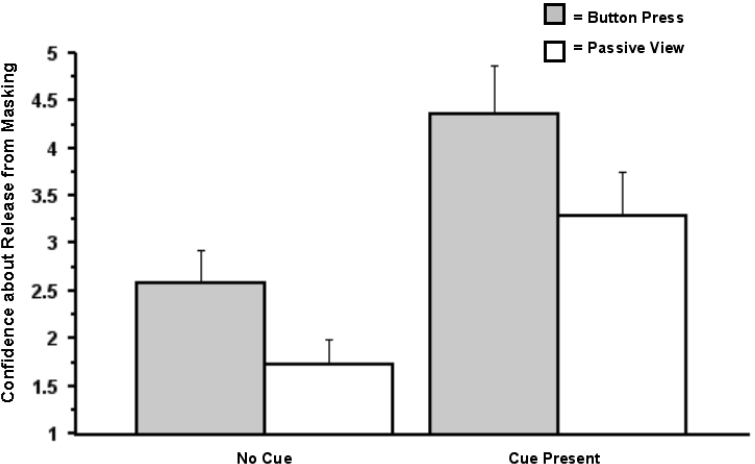
Figure 5. Confidence regarding judgments about release from masking (Experiment 1). The data presented here stem from the question, “How confident are you that you saw something other than the pattern